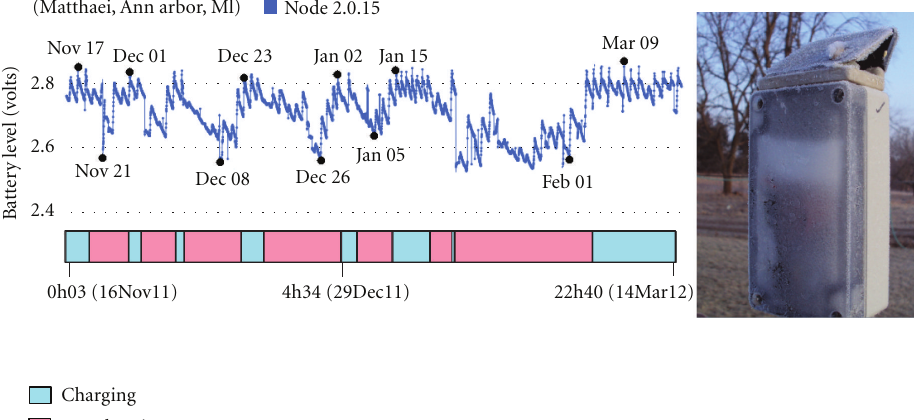
Figure 1: Even with su ffi cient solar irradiation in some days, the e ffi ciency of the recharging process of two NiMH cells (1.5V nominal voltage each) is drastically impacted by extreme low temperatures ( < 0 ◦ C). Also, the e ffi ciency of a solar panel, in particular a small one, is strongly impacted by snow and